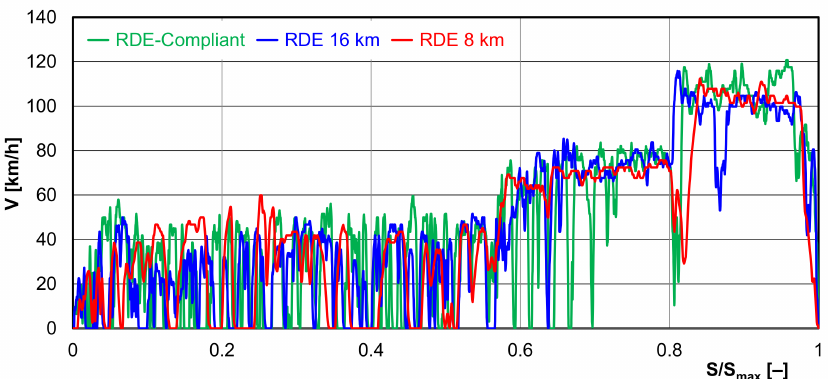
Figure 2. Relative length (related to total length) of tests: RDE-Compliant (green line), RDE 16 km (blue line) and RDE 8 km (red line).